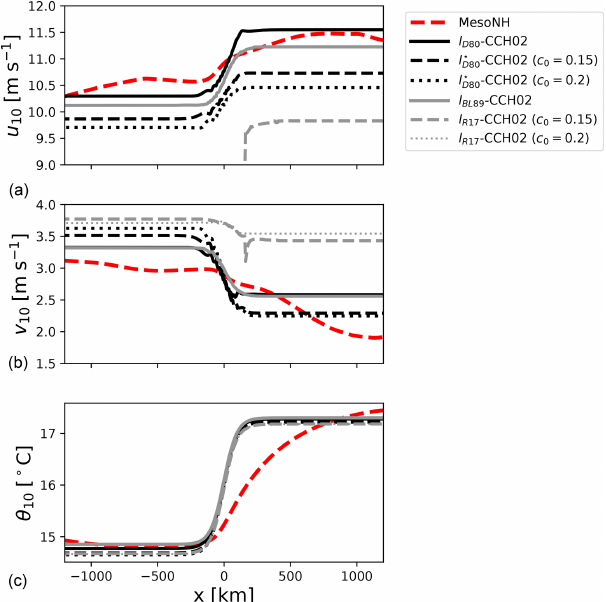
Figure 7. Zonal (a) and meridional (b) components of 10m winds and 10m temperature (c) for the reference MesoNH simulation (dashed red) and for ABL1d simulations with different mixing- length formulations for the winds across a midlatitude SST front